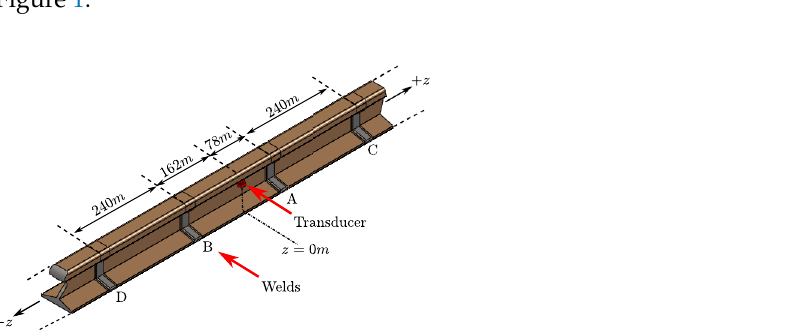
Figure 1. Schematic representation of a considered section of an operational rail containing four welds.